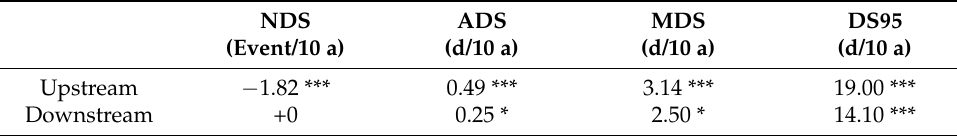
Figure 5. Temporal variations of Gini CI in ( a ) the upper region and ( c ) the lower region from 1977 to 2017. The Lorenz curve of the cumulative of rainy days and precipitation percentage distribution of ( b ) the maximum CI upstream and ( d ) minimum CI downstream. Table 6. Trends in indices, in the dry spell over the LRB during 1977–2017.